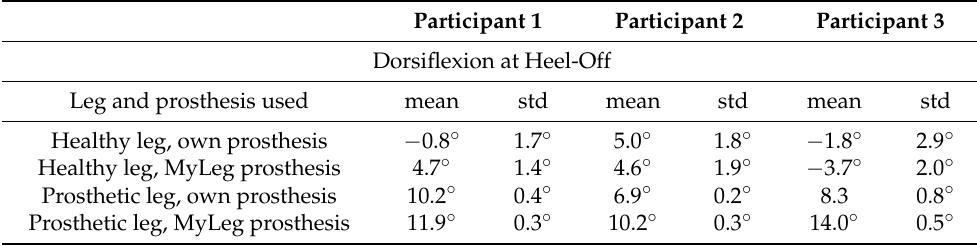
Table 6. Dorsiflexion at heel-off. Mean values (mean) and standard deviations (std) are calculated from 50 gait